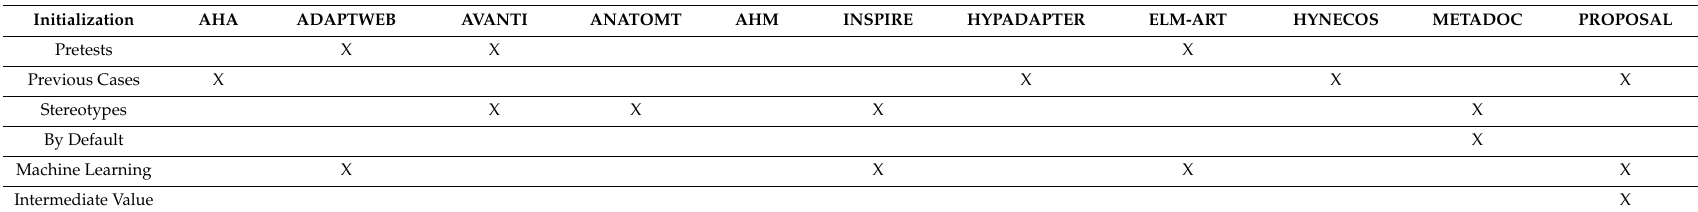
Table 1. Comparison between the initialization process of a learner model between alternative systems and our proposal. The original table and comparison is based on research by Tadlaoui, Carvalho and Khaldi